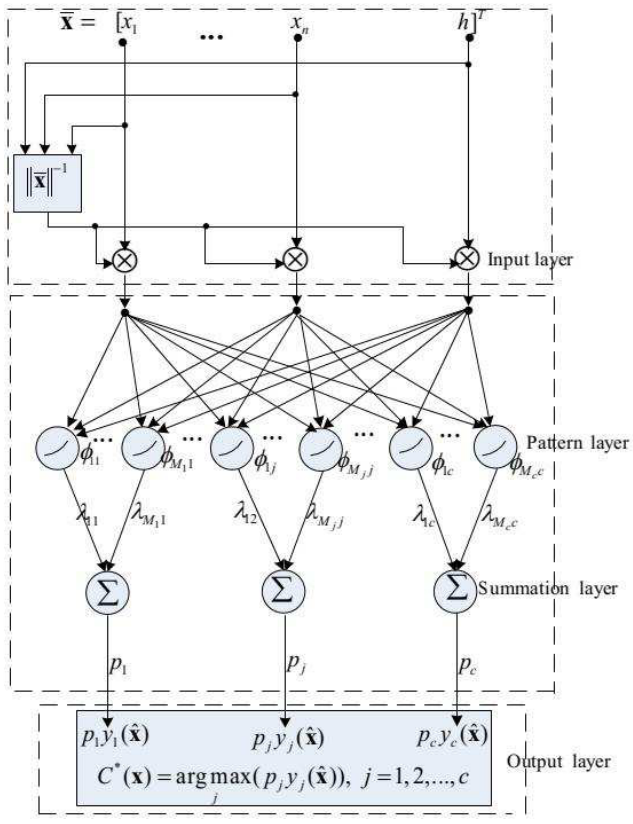
Figure 4. The overall structure of the SOPNN